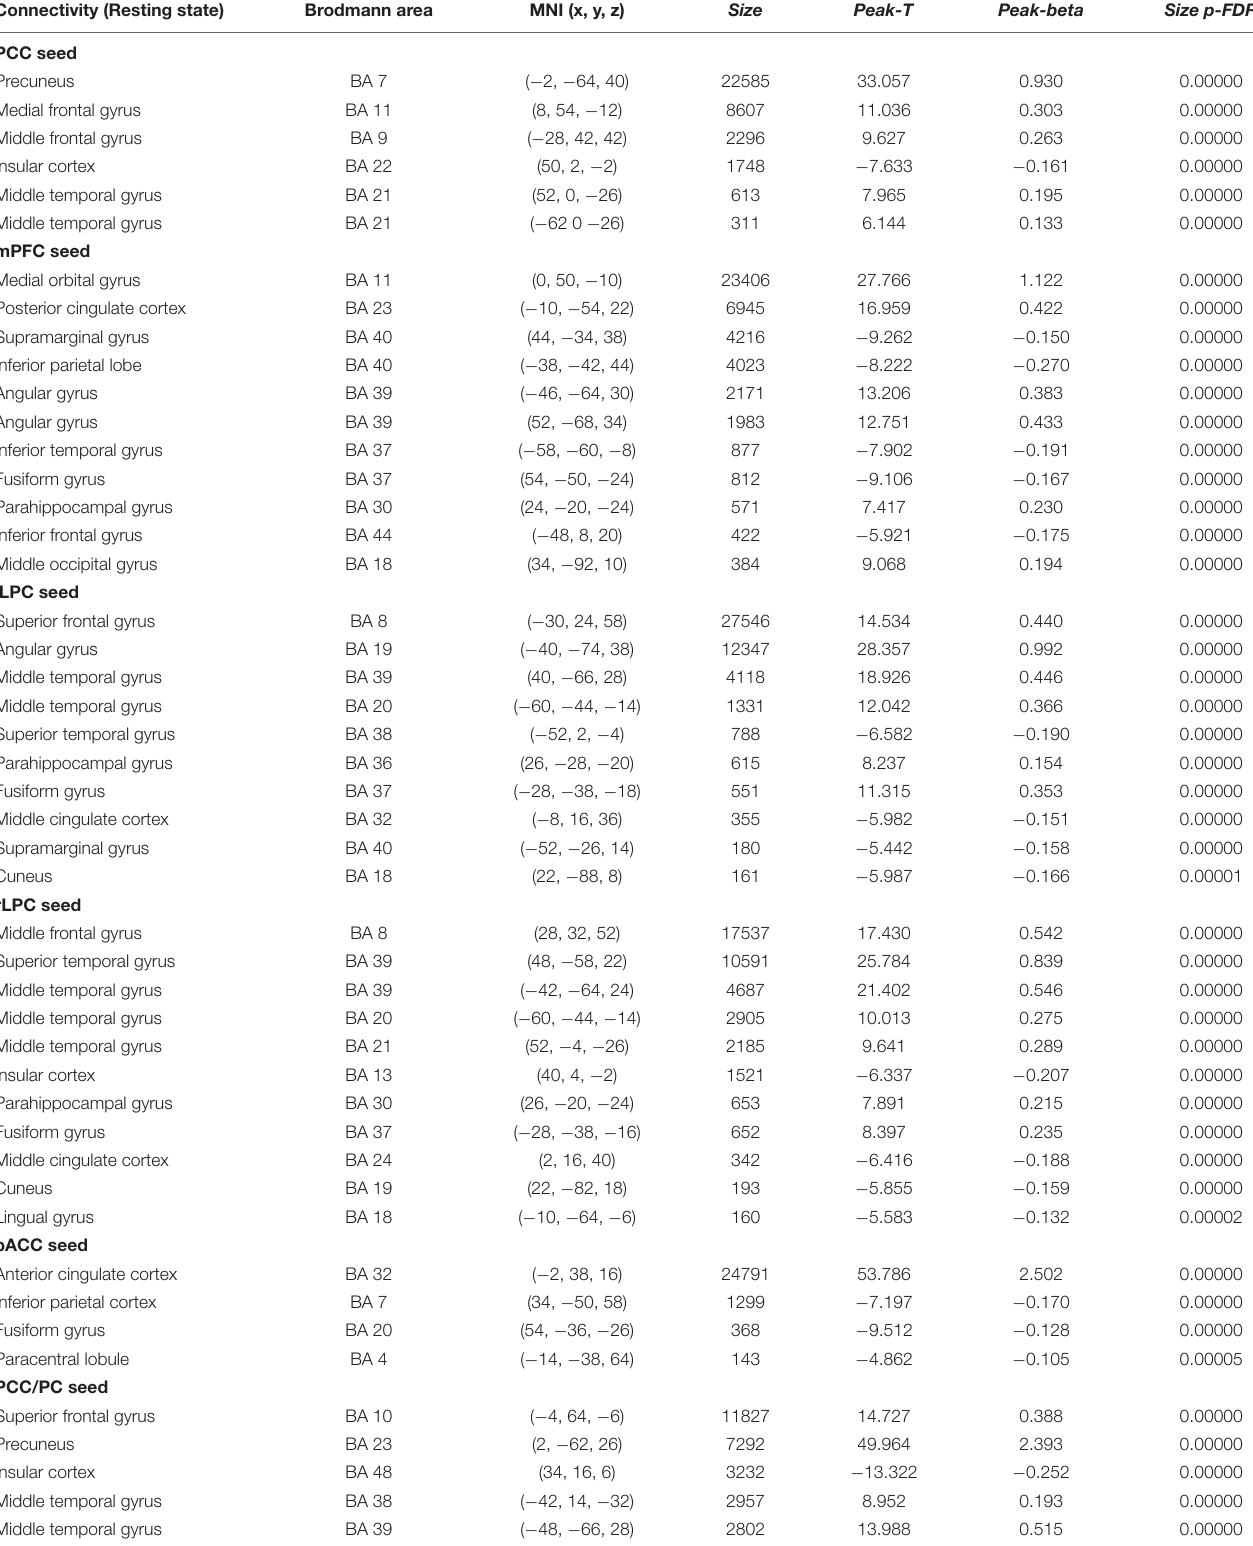
TABLE 2 | Statistical significance of the group-level functional connectivity generated during resting-state condition. Connectivity (Resting state) Brodmann area MNI (x, y, z)